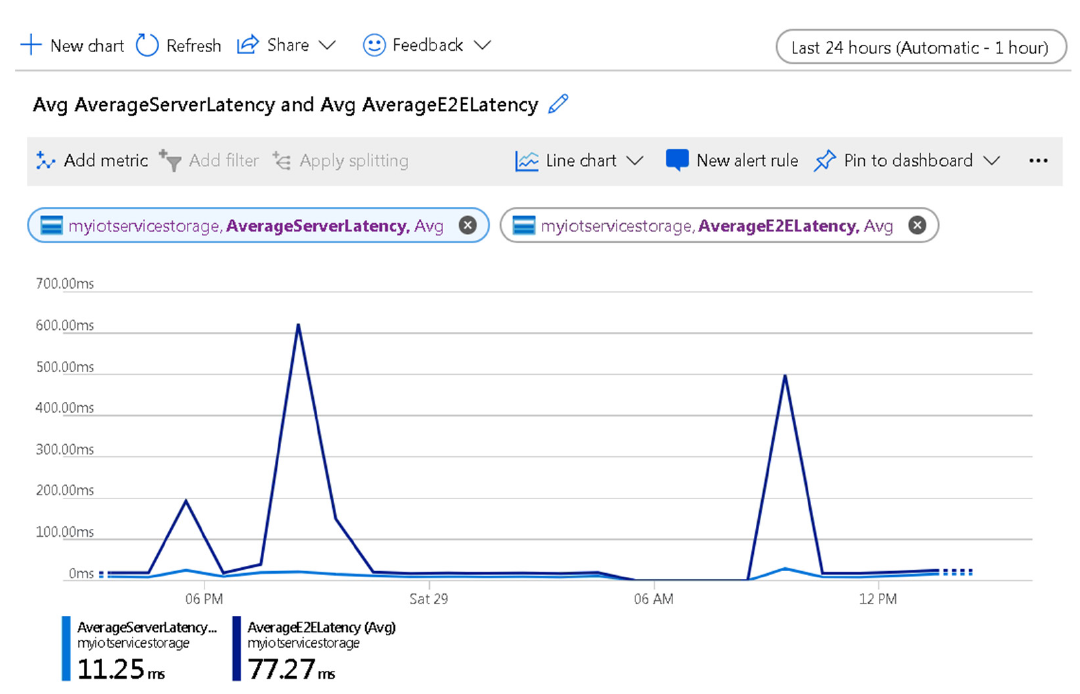
Figure 14. Latency evaluation for Azure Table Storage.